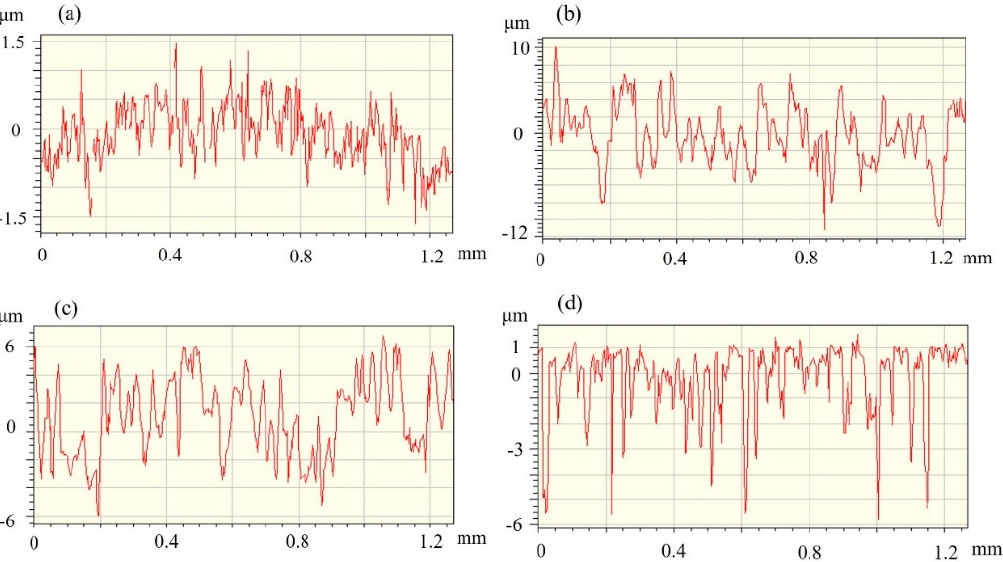
Figure 3. Roughness profiles of surfaces with different treatments: ( a ) sandpaper abrading, ( b ) sandblasting, ( c ) chemical etching, and ( d ) PAA.